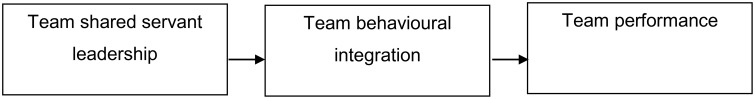
Conceptual model relating the variables of shared servant leadership, team behavioral integration, and team performance.